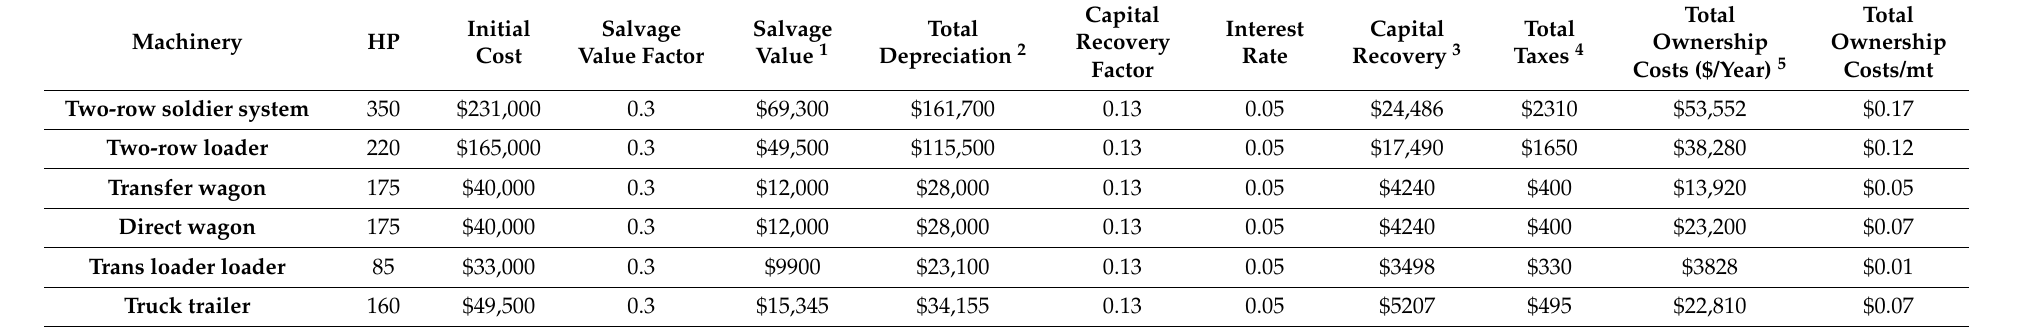
Table 5. Estimated ownership costs of machinery in harvesting and hauling unit.